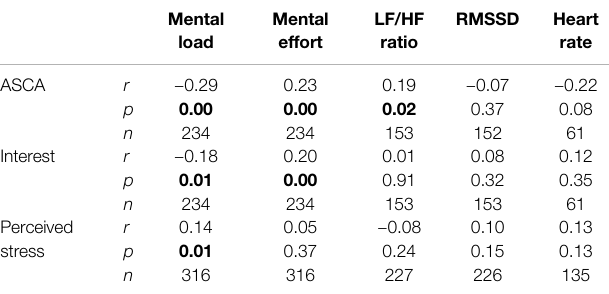
TABLE 6 | Pearson correlation coef fi cients r between ASCA, interest, perceived stress, and subjective and objective measures of cognitive load for the total sample.